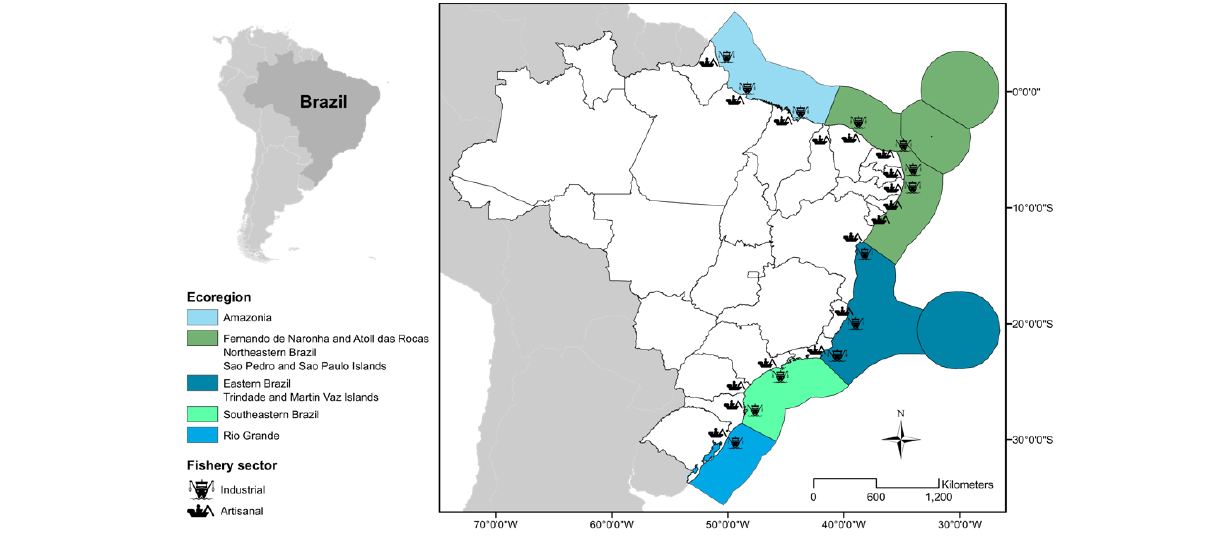
Fig. 2 . Study area encompassing 17 coastal states distributed over 5 marine ecoregions, according to the ecoregions proposed by Spalding et al. (2007), along the Brazilian coastline (ecoregions presented from north to south). State fisheries sectors are identified on the